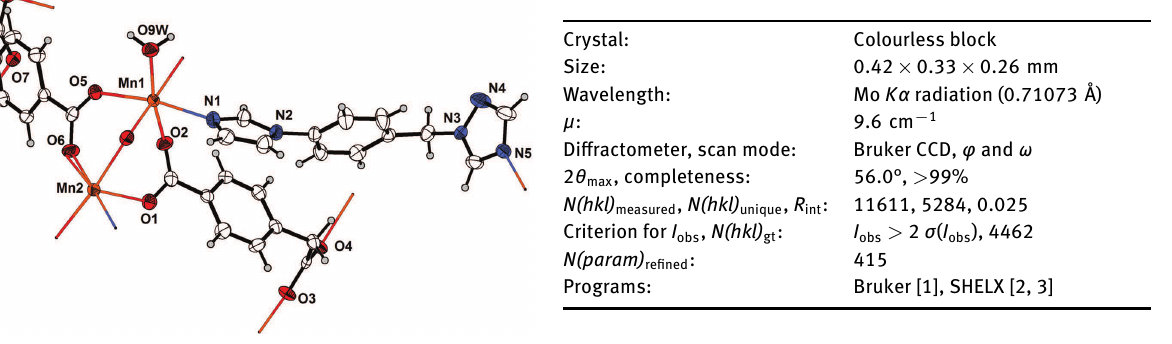
Table 1: Data collection and